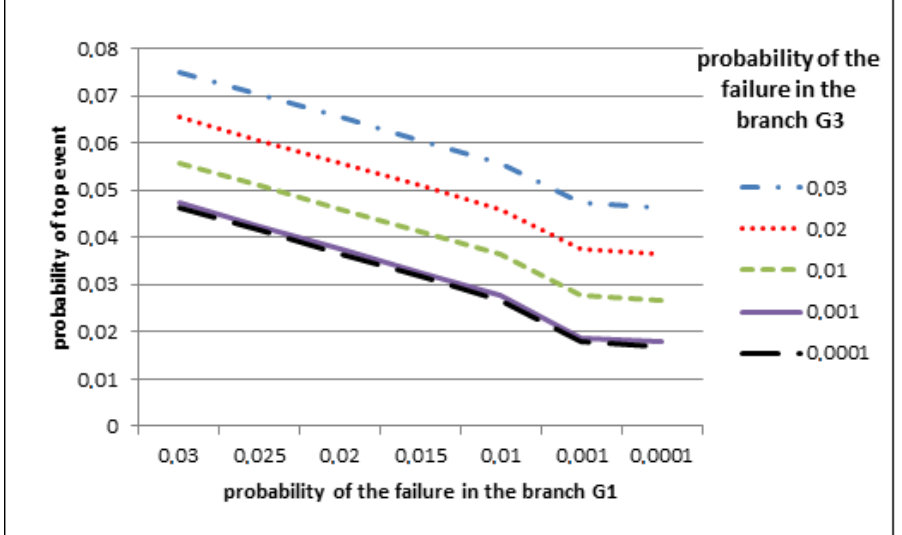
Figure 3. The relationship between the probability of failure in branches G1 and G3 and the probability of the top event.